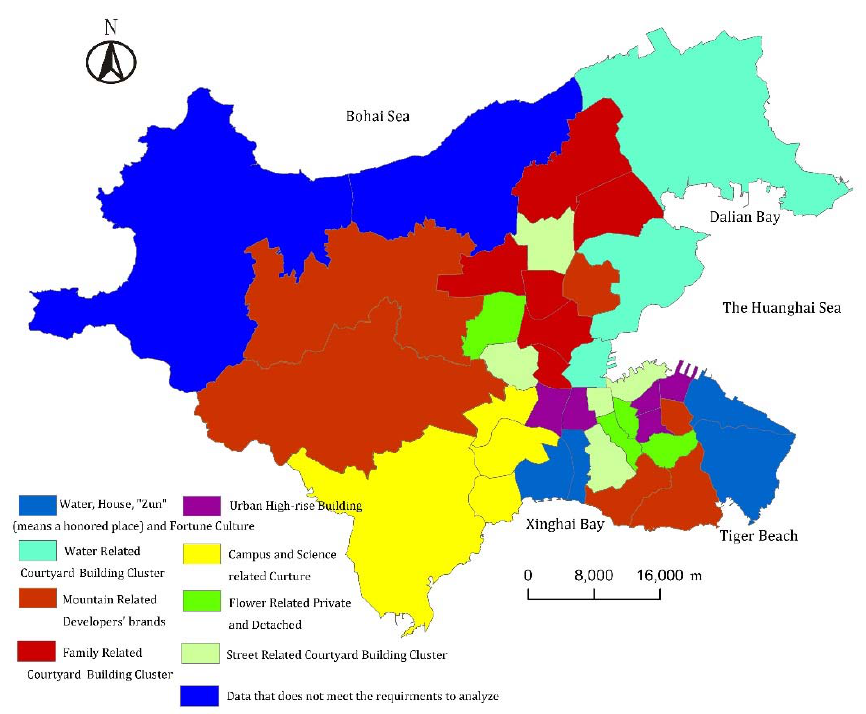
Figure 5. The spatial features of pseudo ‐ settlements in Dalian.